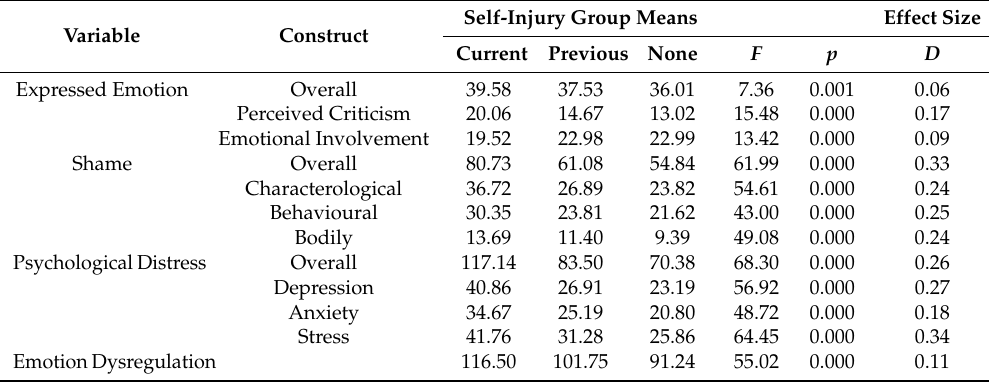
Table 1. Group comparisons and effect sizes (Cohen’s d).